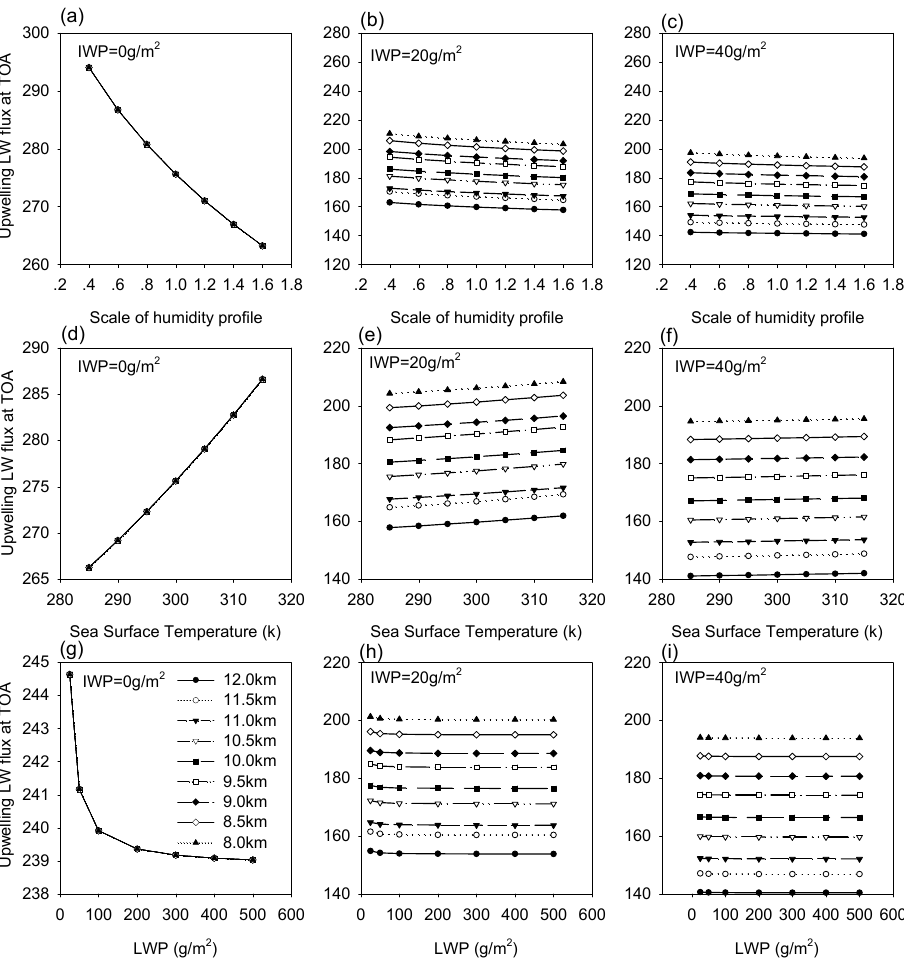
Fig. 5. Simulated OLR as functions of (a–c) changing relative humidity profiles with the ratio of 0.4–1.6 (shown in the x-axis) to the control one, (d–f) changing sea surface temperature from 285 to 315K, and (g–i) changing LWP from 20 to 500gm − 2 of the second cloud layer. Clouds with different IWPs (0, 20, and 40 g/m 2 , from left to right) and different cloud top temperatures (different symbols, see Fig. 5g) are tested .